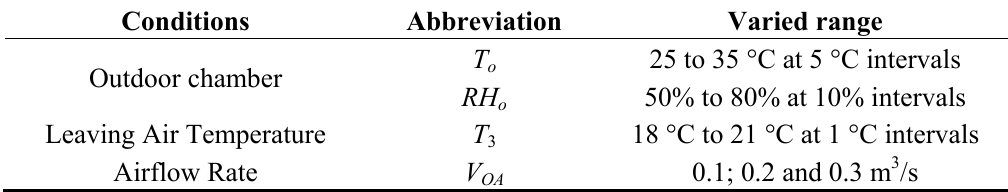
Table 2. Controlled conditions during experiments.